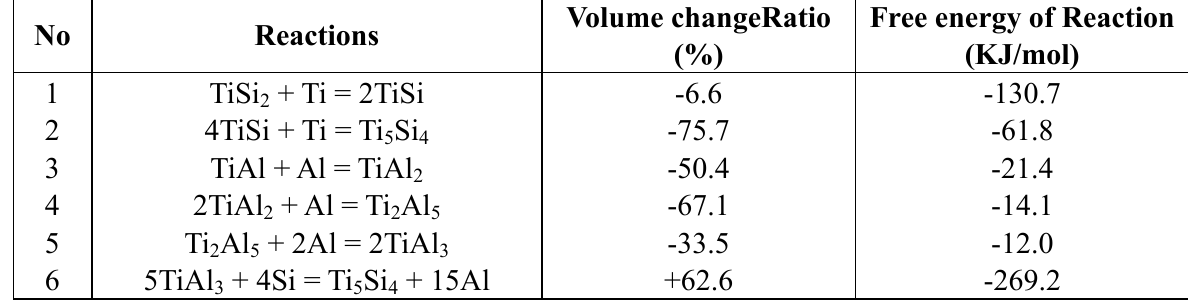
Table 5. The calculated volume change ratio and reactions.